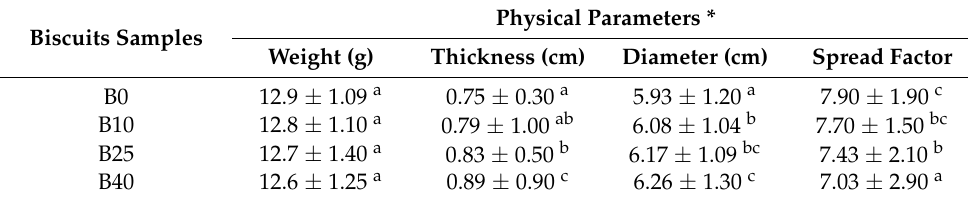
Table 7. Physical characteristics of biscuits. Biscuits